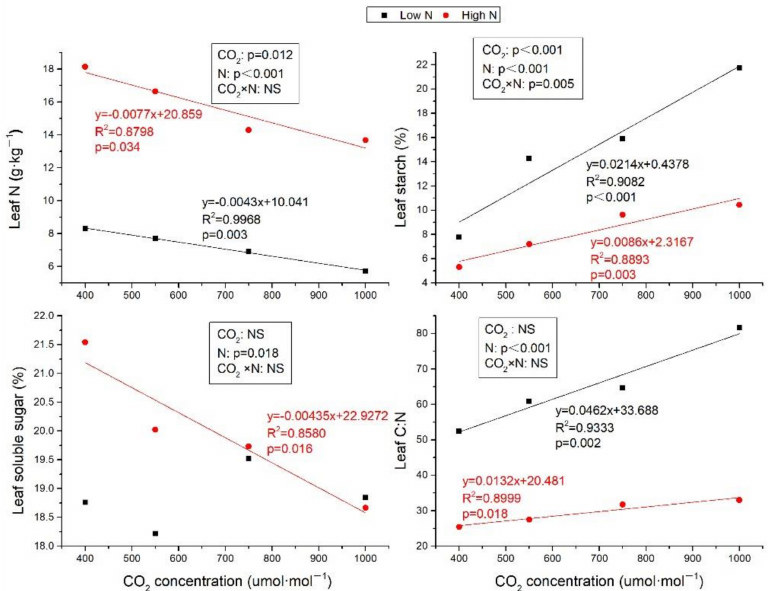
Figure 1. The different effects of elevated CO 2 on leaf N, carbohydrates and leaf C:N between low N and high N treatments. The results of two-factor analysis were also shown. NS: not significant. Leaf N, soluble sugar, and starch were all calculated by dry mass. Values are means ± SE (n = 6).